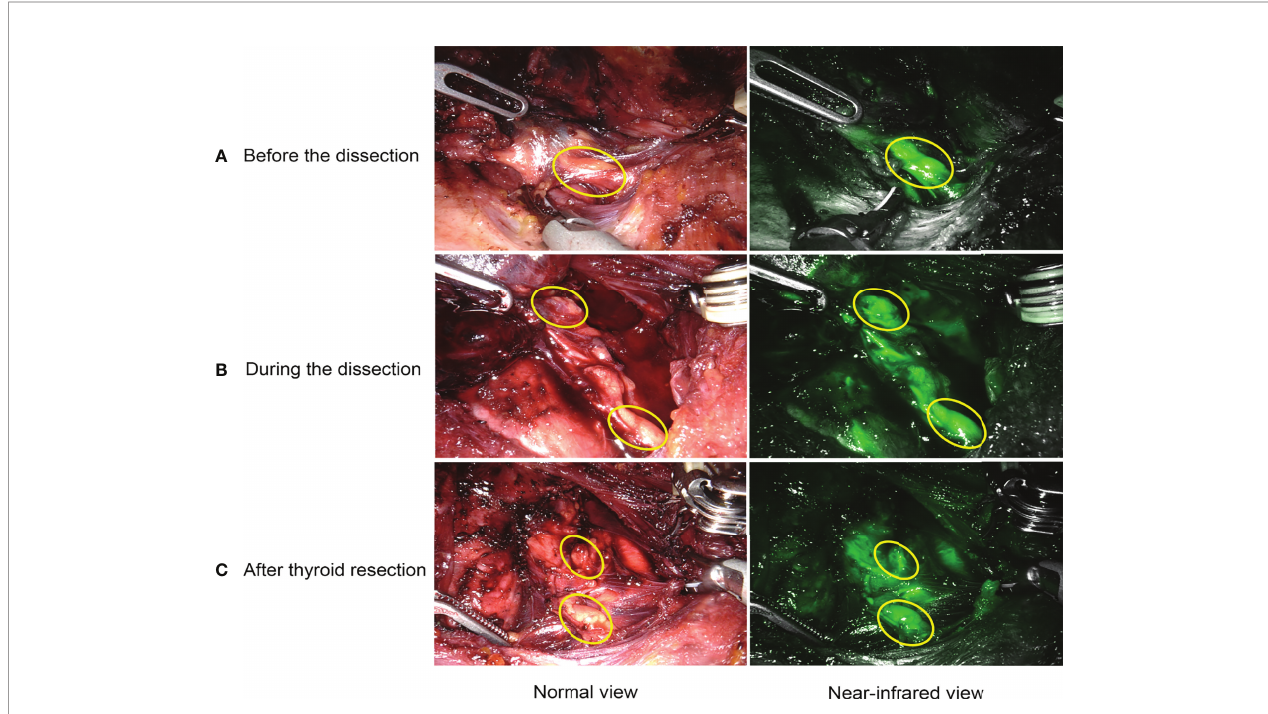
FIGURE 2 | Intraoperative application of ICGA. (A) detection and identi fi cation of PGs. (B) real-time visualization and preservation of PGs and their vascularization during the dissection. (C) evaluation of viability and function of PGs after thyroid